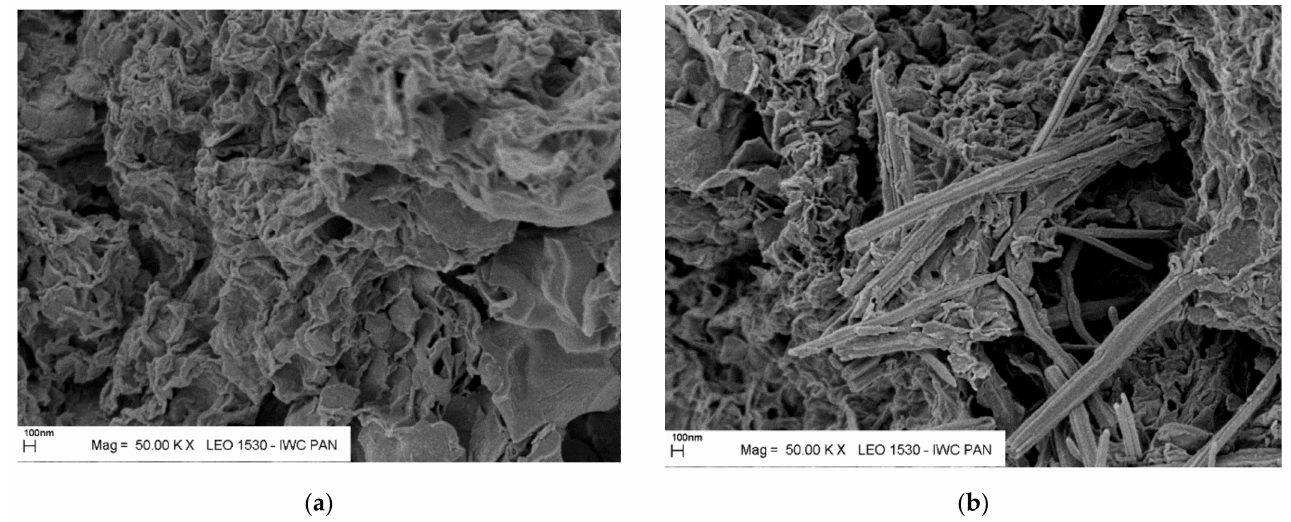
Figure 5. Change of eluate properties depending on cumulative L/S ratio, hardening slurry: ( a ) change of pH; ( b ) change of specific conductance.